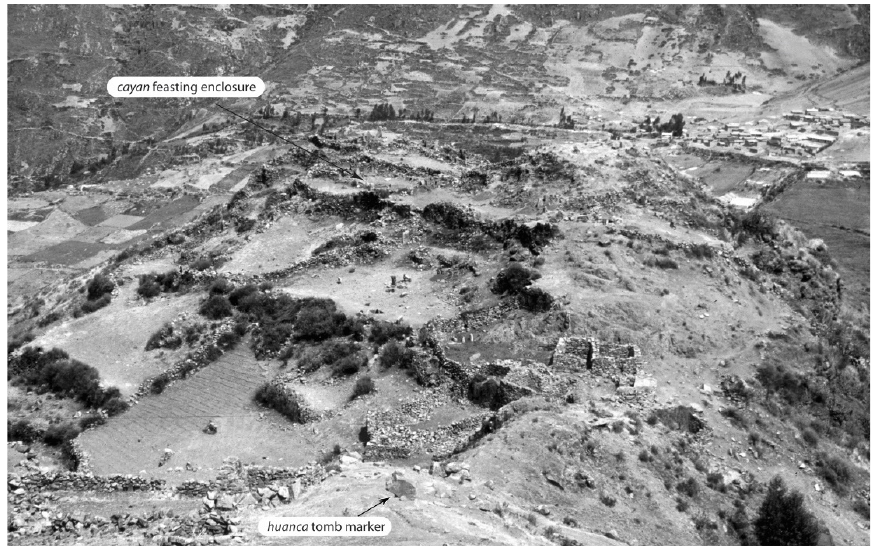
Figure 7. Photograph of Chinchawas, showing the main settlement mound and locations of a ceremonial enclosure (perhaps a ‘ cayan’ ) and a standing upright ( huanca ). Over 40 carved stone monoliths were identified across the site. Photograph by author.